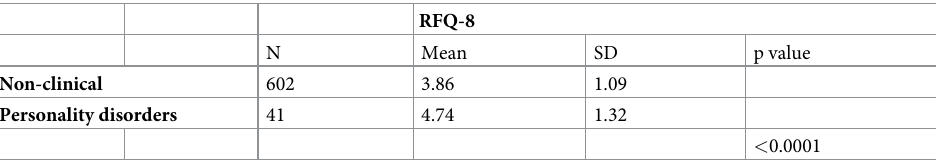
Table 5. Group differences between the non-clinical and the clinical